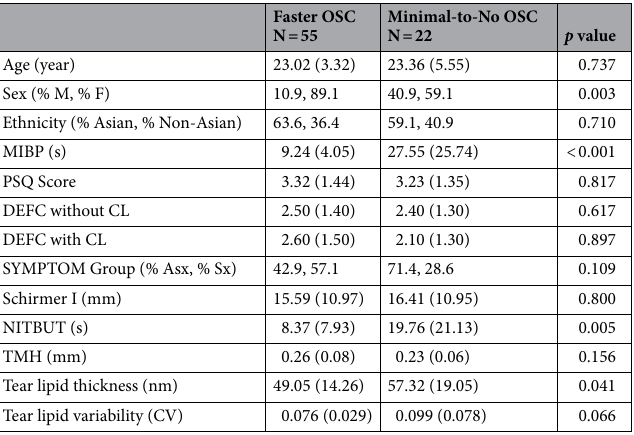
Table 1. Comparison of mean (SD) for subjective responses and clinical tests between the faster OSC and minimal-to-no OSC